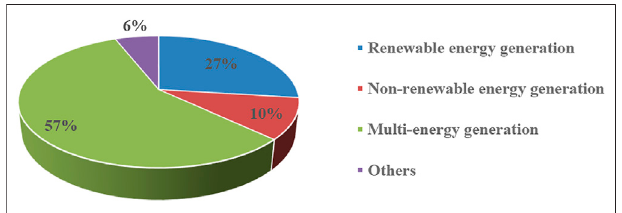
FIGURE 5 | Percentage of energy types